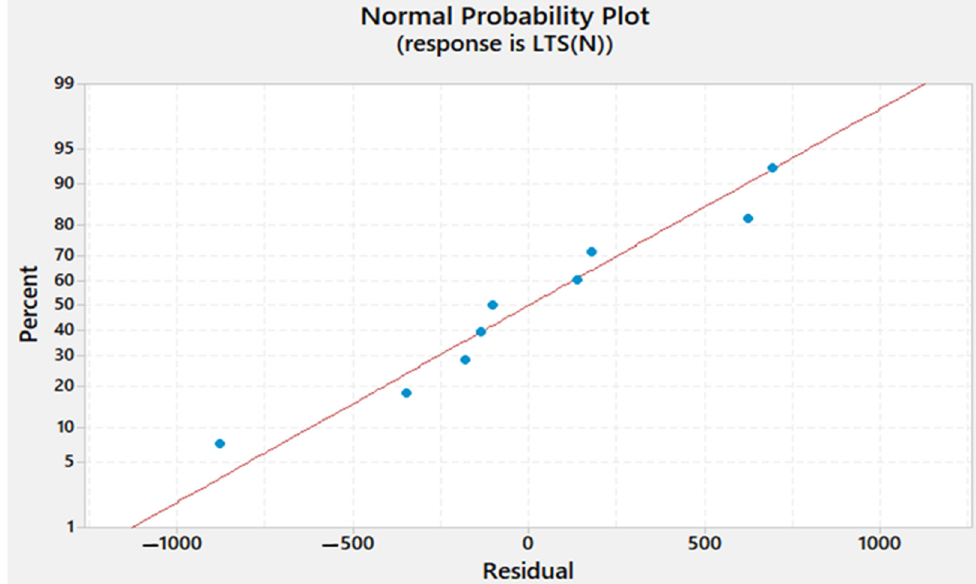
Figure 14. Normal probability plot of the residuals for the TSL.